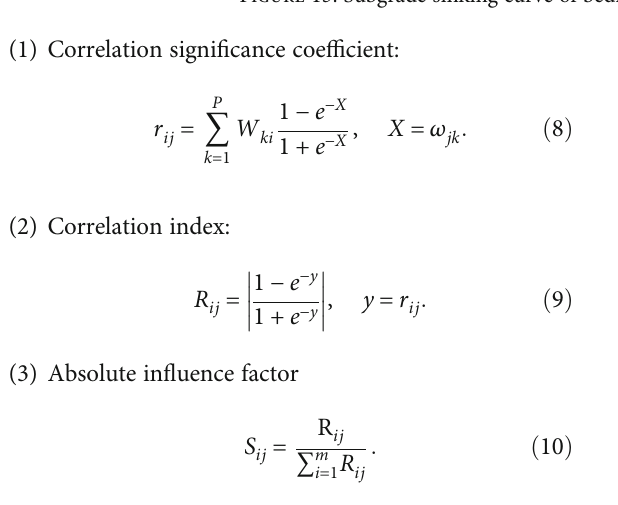
Figure 15: Subgrade sinking curve of bedrock with di ff erent stratum